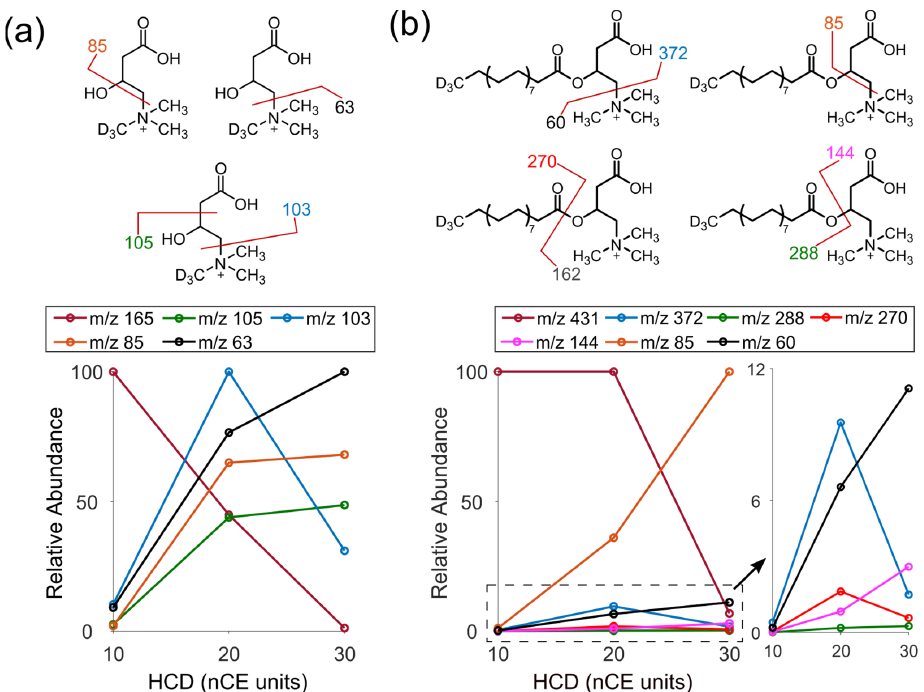
Figure 2. Fragmentation studies of C18-AC-d3 and C-d3 by MS/MS and varied collision energy. Proposed fragmentation sites and relative abundance of product ions for ( a ) C-d3 and ( b ) C18-AC-d3. The fragments of m/z 63 and 60 both correspond to the trimethylamine group but with and without three deuterium atoms,